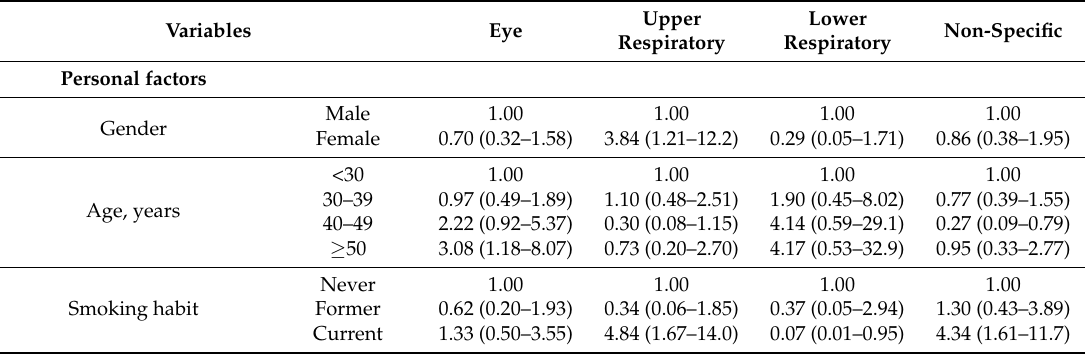
Table 3. Adjusted odds ratios of sick building syndrome symptoms in relation to personal, psychosocial, and environmental factors ( n =